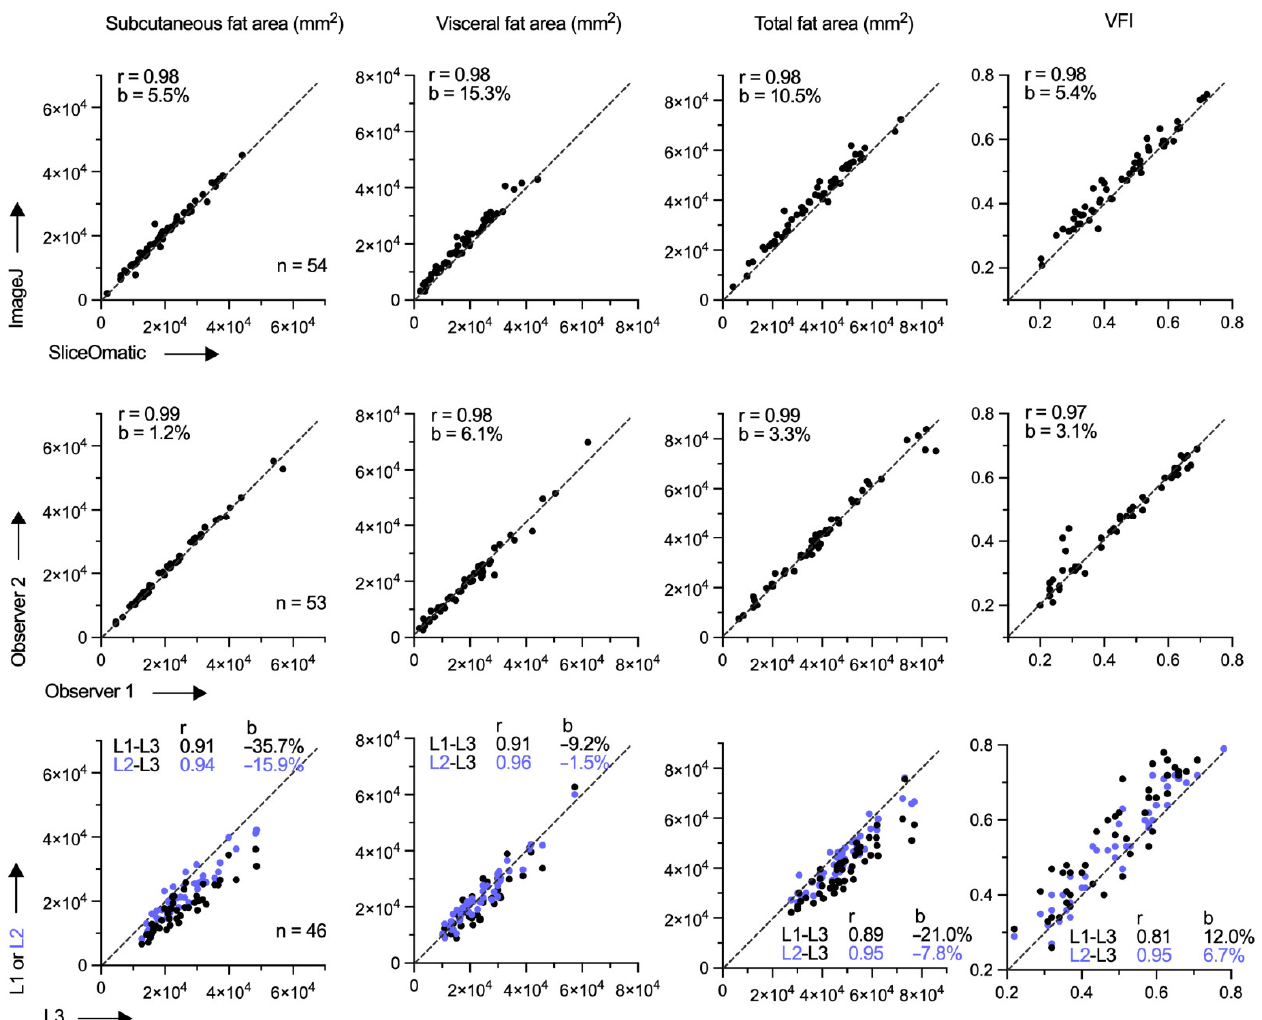
Figure 1. Quantification of abdominal fat in computerized tomography images. Axial cross-sectional body images of non-small cell lung cancer patients at the level of L1, L2, or L3 lumbar vertebrae were analyzed with methods using ImageJ or sliceOmatic software to quantify areas of subcutaneous and visceral abdominal fat deposits. Visceral fat index (VFI) was defined as the ratio of visceral to the sum of subcutaneous and visceral fat tissue areas. Concordance of the measurements between the different software (same observer; n = 54), two observers (using ImageJ; n = 53), and different vertebral levels (same observer using ImageJ; n = 46) is depicted with scatterplots that also show the number of examined cases (n) and values of Pearson correlation coefficient (r) and Bland–Altman bias (b).